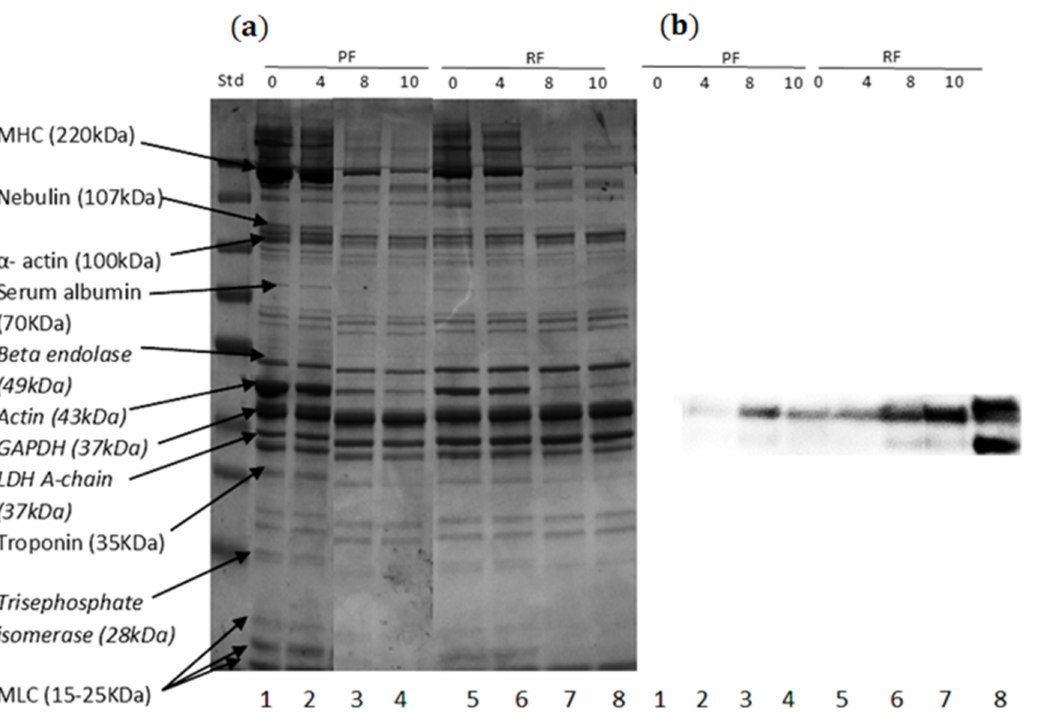
Figure 5. ( a ) SDS-polyacrylamide gel electrophoresis, ( b ) immunoblotting against protein carbonyl groups in perch fillet from pond (line 1–4) and RAS (line 5–8) systems during frozen storage at − 20 ◦ C. Line (1) t = 0, pond fillet; (2) 4 months, pond fillet; (3) 8 months, pond fillet; and (4) 10 months; (5) at t = 0, RAS fillet; (6) 4 months, RAS fillet; (7) 8 months, RAS fillet; and (8) 10 months, RAS